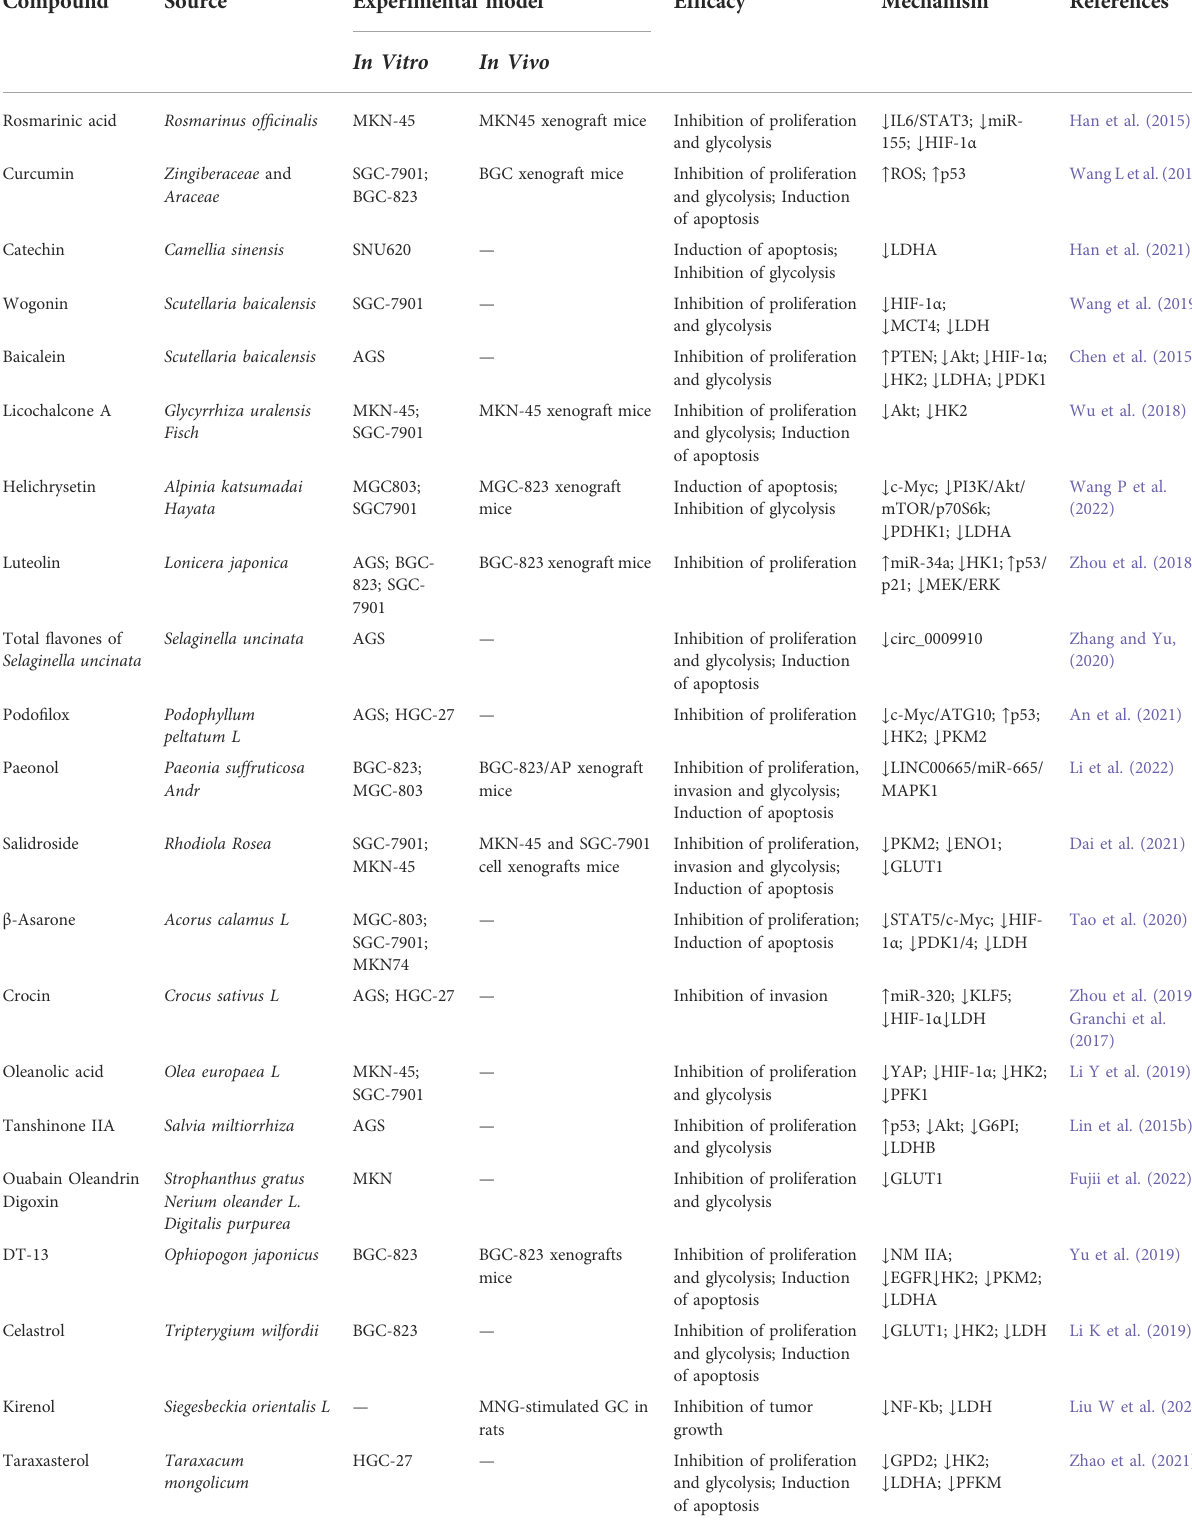
TABLE 1 Phytochemicals targeting the glycolysis for gastric cancer therapy. ( ↑ increase, ↓ decrease).